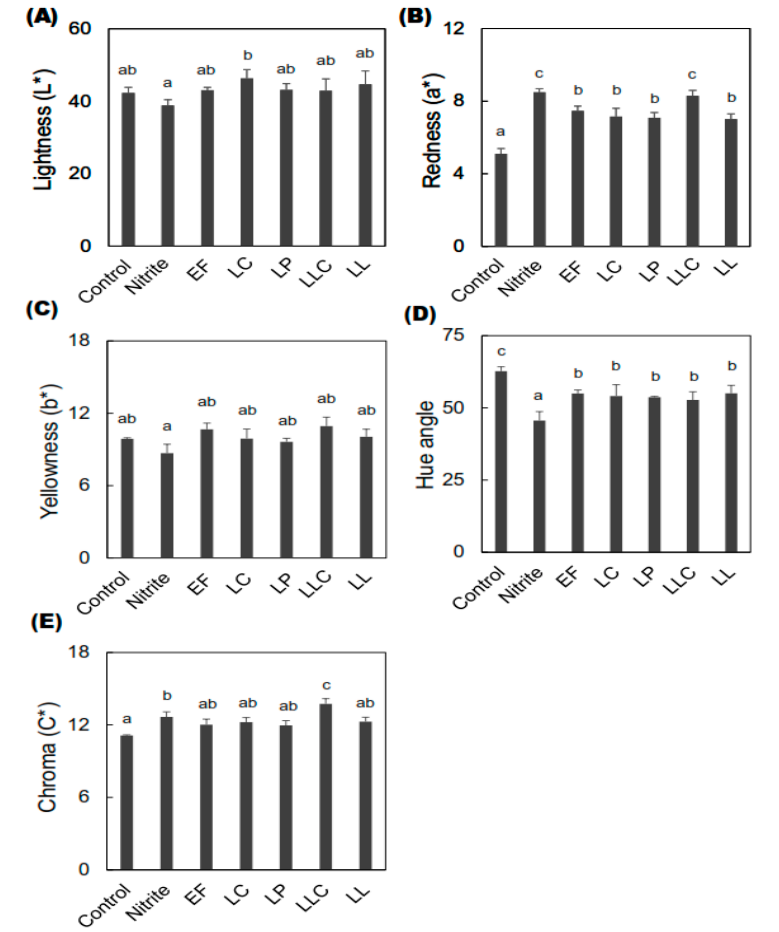
Figure 4. Effects of high ZnPP-forming LAB on the internal color profiles of dry-cured fermented sausages. To measure the color of the inner side of the sausages after 28 days of ripening, the sausages were cut into 2.5 cm thickness with uniform shape and exposed to air for about 1 h to bloom. The figures indicate ( A ) lightness (L*), ( B ) redness (a*), ( C ) yellowness (b*), ( D ) hue angle, and ( E ) chroma (C*) values of the sausages at the end of ripening. Bars represent standard errors of the means ( n = 2). a–c: columns with di ff erent letters in the di ff erent groups di ff er significantly ( p < 0.05). ZnPP: zinc protoporphyrin